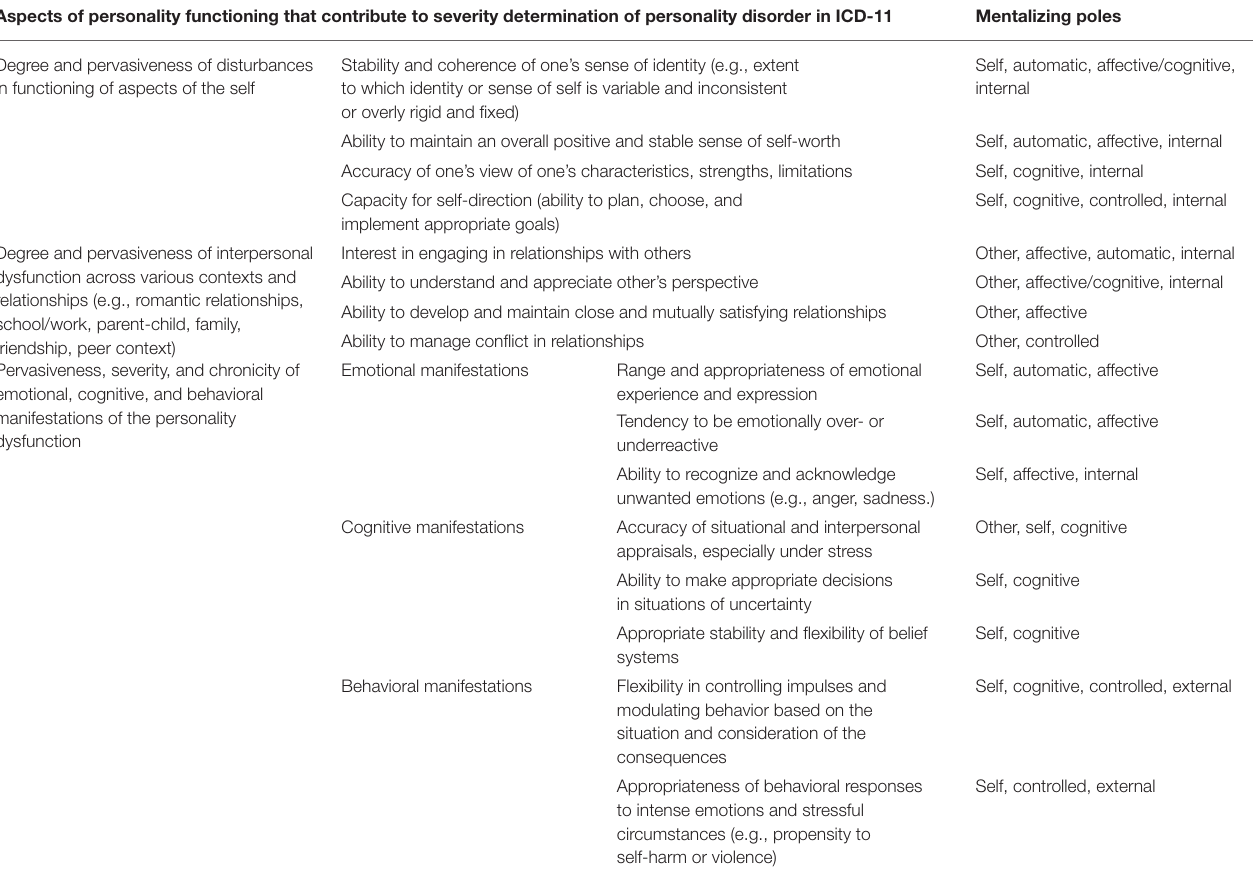
TABLE 1 | Tentative “Cross Walk” for personality functioning and mentalizing poles. Aspects of personality functioning that contribute to severity determination of personality disorder in